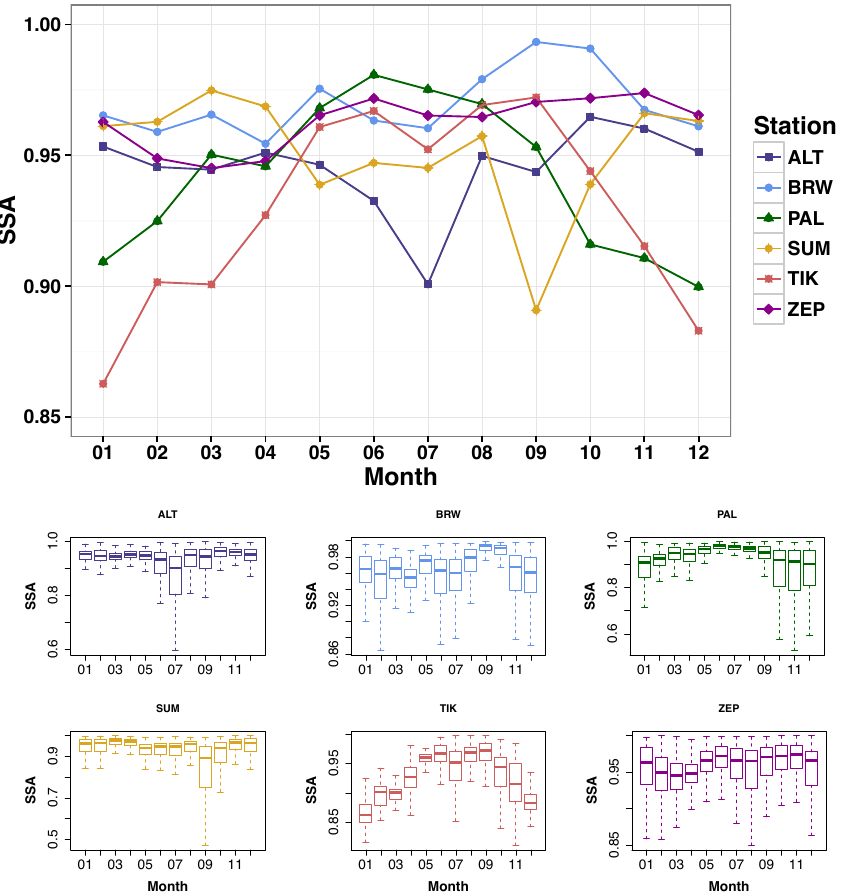
Figure 5. Seasonality of single-scattering albedo (SSA) at all sites. Large plot shows monthly medians of hourly average SSA at 550nm at each station; subplots below show boxplots of SSA at individual sites, with horizontal line at the median, edges of the box at 25th and 75th percentiles, and whiskers at 5th and 95th percentiles. Note that y axes are different on each